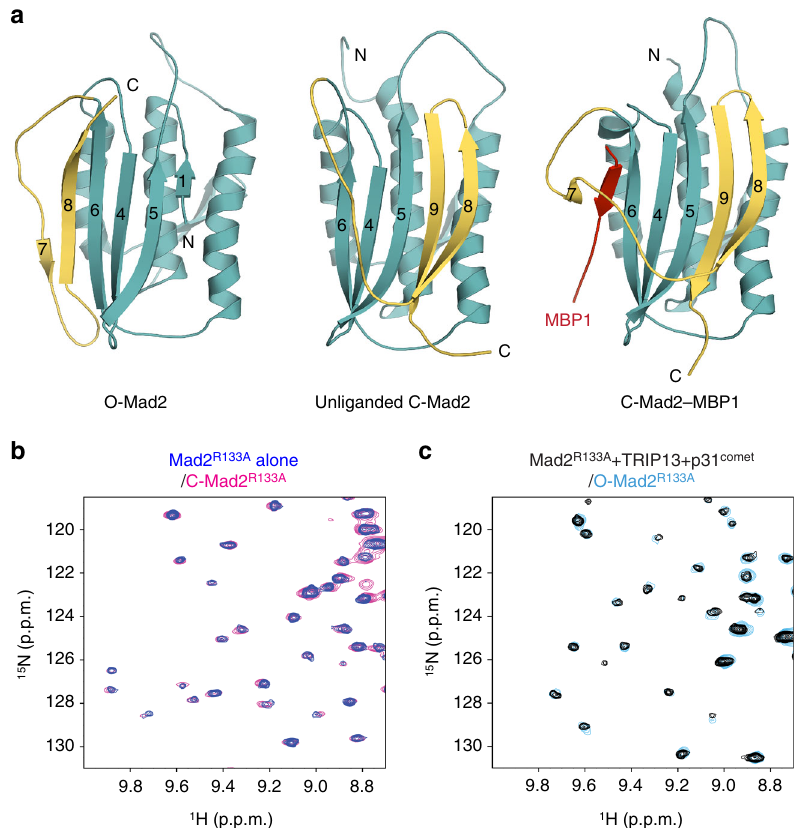
Fig. 1 TRIP13 catalyzes C-Mad2 to O-Mad2 conversion in the presence of p31 comet . a Ribbon diagrams of O-Mad2 (left), unliganded C-Mad2 (middle), and C-Mad2 bound to its high-af fi nity arti fi cial ligand MBP1 (right). The C-terminal region that undergoes a large conformational change and forms the safety belt structure in C-Mad2 is colored yellow while the rest of the protein is in cyan. Strands in the major β sheet are labeled with their numbers. The N- and C-termini are indicated. All protein structure fi gures in this study were generated with PyMOL (Schrödinger, LLC; http://www.pymol.org). b Overlay of regions of the 1 H – 15 N HSQC spectra of 15 N-C-Mad2 R133A (in magenta) and 15 N-Mad2 R133A before the addition of TRIP13 and Δ N35-p31 comet (in blue). c Overlay of regions of the 1 H – 15 N HSQC spectra of 15 N-O-Mad2 R133A (in cyan) and 15 N-Mad2 R133A after the addition of ATP and sub-stoichiometric amounts of TRIP13 and Δ N35-p31 comet (in